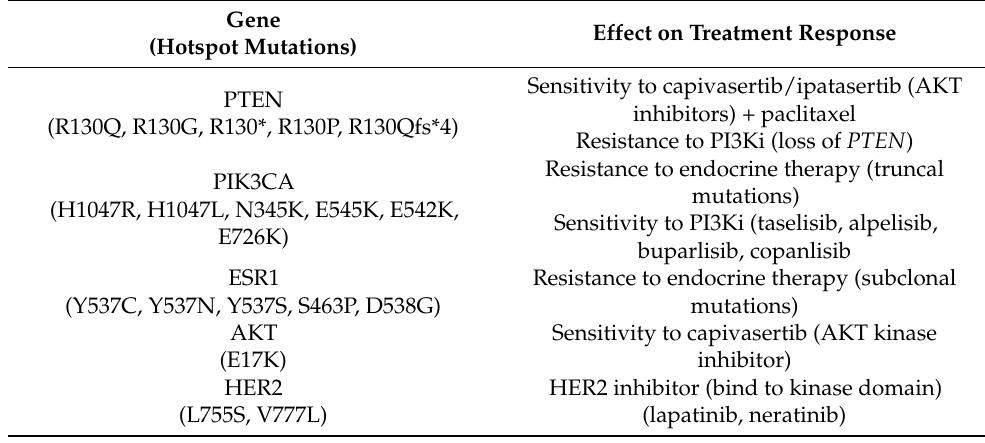
Table 2. Druggable target gene alterations detected in ctDNA in metastatic breast cancer. * (asterisk) means translation termination (stop)